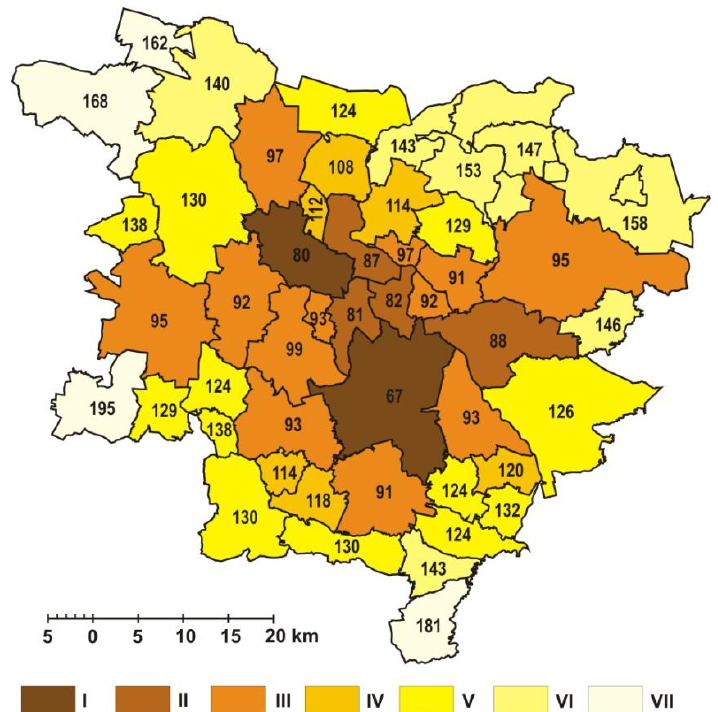
Fig. 3. Average time of transit to other communities by public transportation (in route „there” and